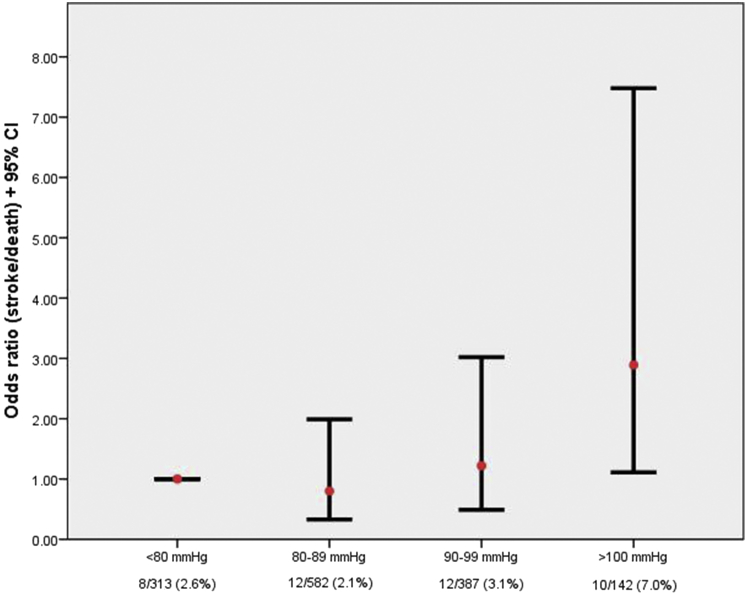
Odds ratios and observed risk for peri-procedural stroke/death (95% confidence interval [CI]) for increasing levels of diastolic blood pressure measured at baseline.